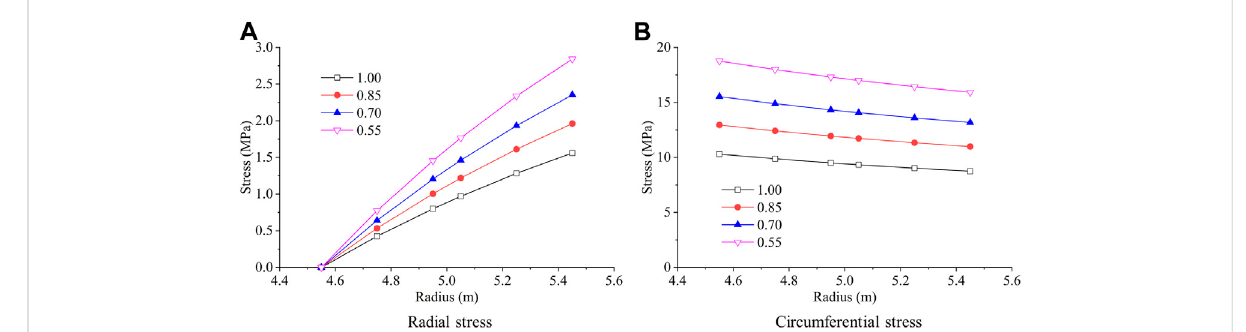
FIGURE 11 In fl uence of deterioration coef fi cient k d under state TF.